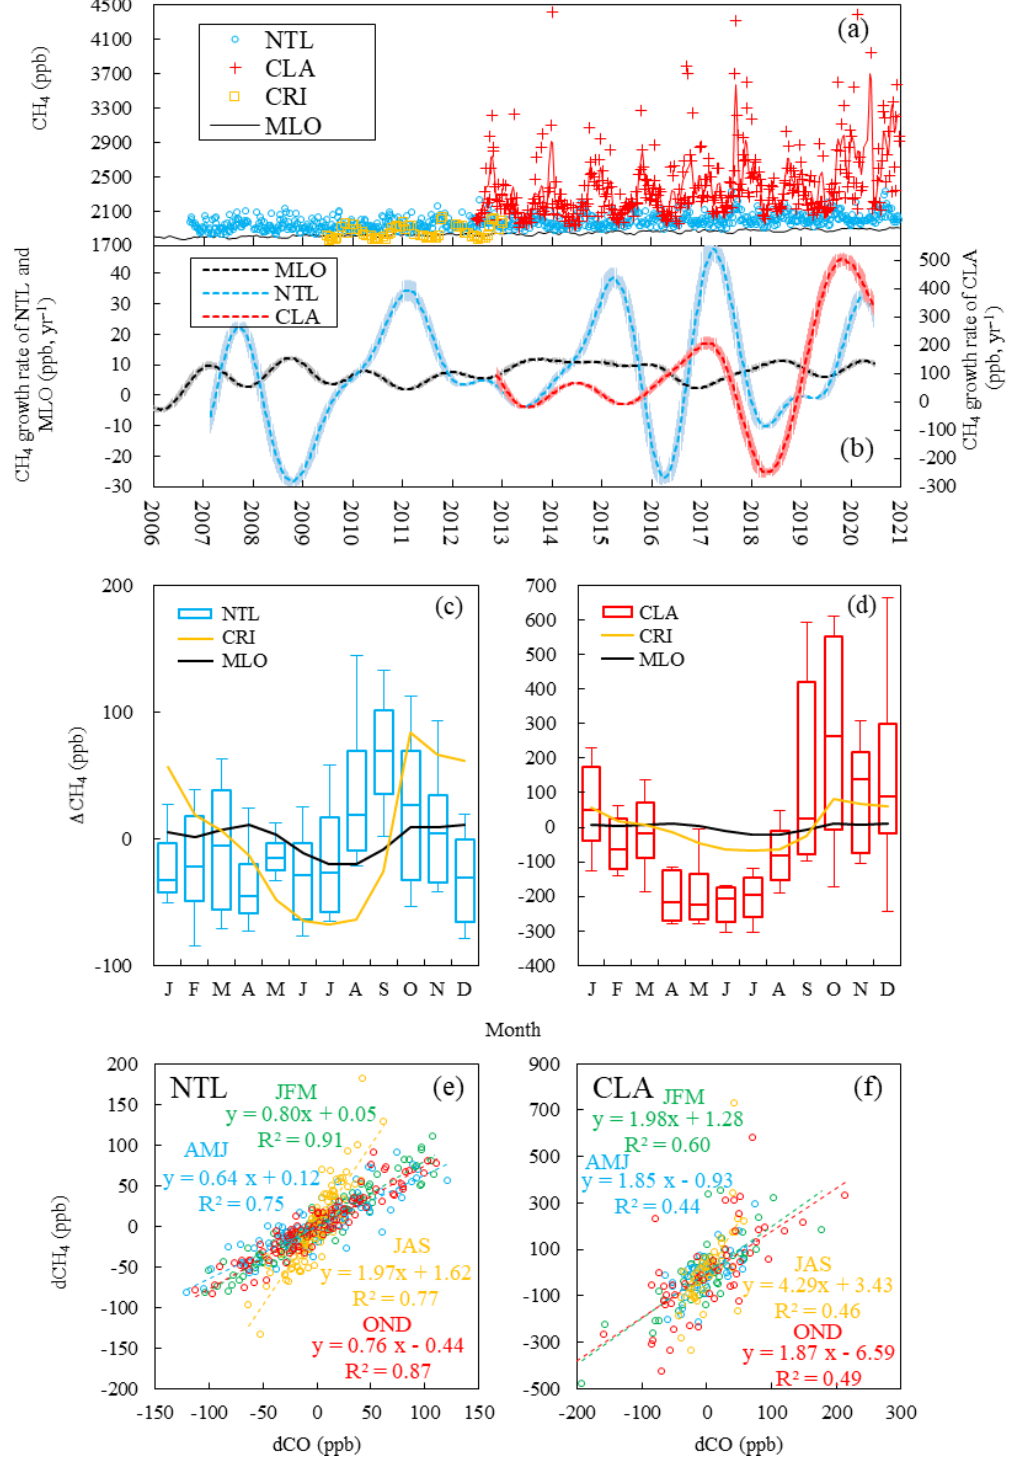
Figure 9. Time series of (a) measured values and (b) growth rates of the CH 4 mole fraction at NTL, CLA, CRI, and MLO in 2006–2020, the seasonal variation in the CH 4 mole fraction at (c) NTL and (d) CLA, and the relationship between the short-term components of dCO and dCH 4 at (e) NTL and (f) CLA during January–March (JFM), April–June (AMJ), July–September (JAS), and October–December